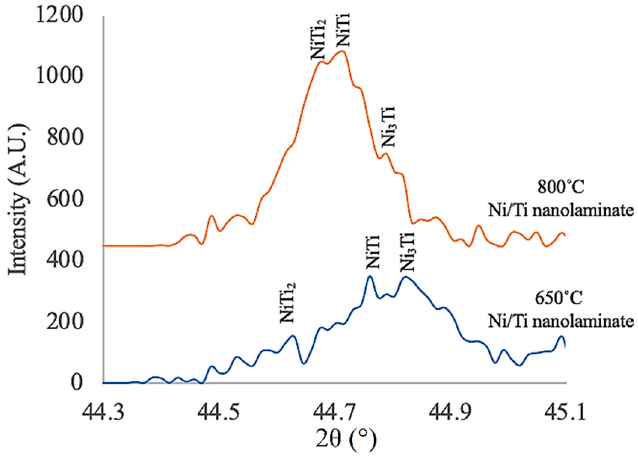
Figure 4. XRD slow-scan of 650 and 800 °C nanolaminate coating around the NiTi (110) peak.